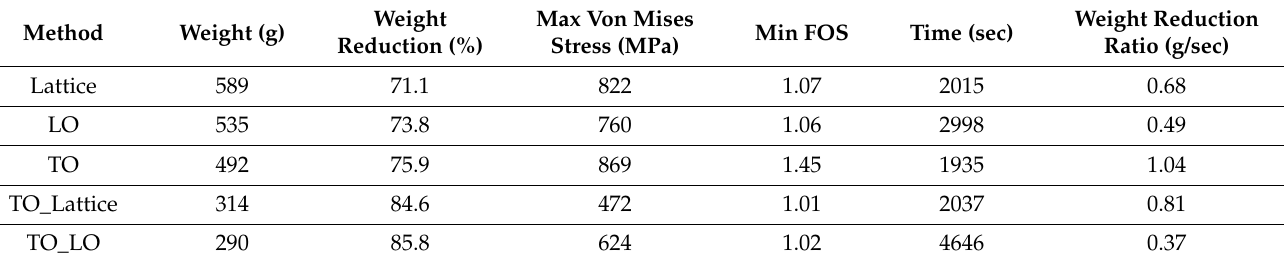
Table 5. The results of the validation studies of the five optimization